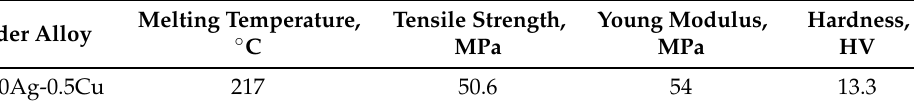
Table 2. Mechanical properties of SAC305 [21].